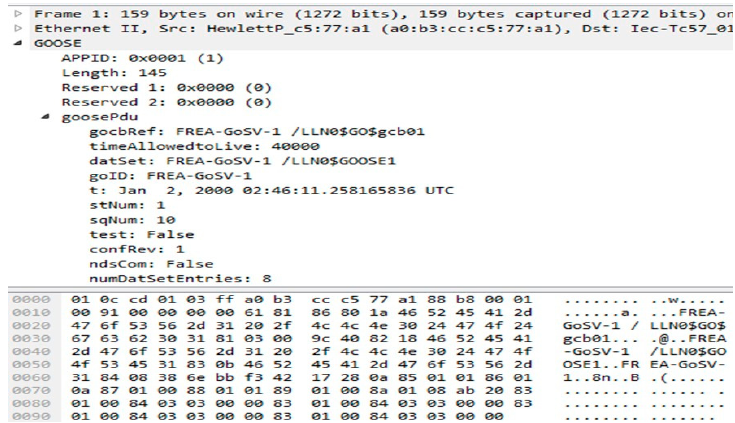
Figure 12. Infotech Avenue Receiver detecting the stream of GoSV software framework. Energies 2018 , 11 , x FOR PEER REVIEW